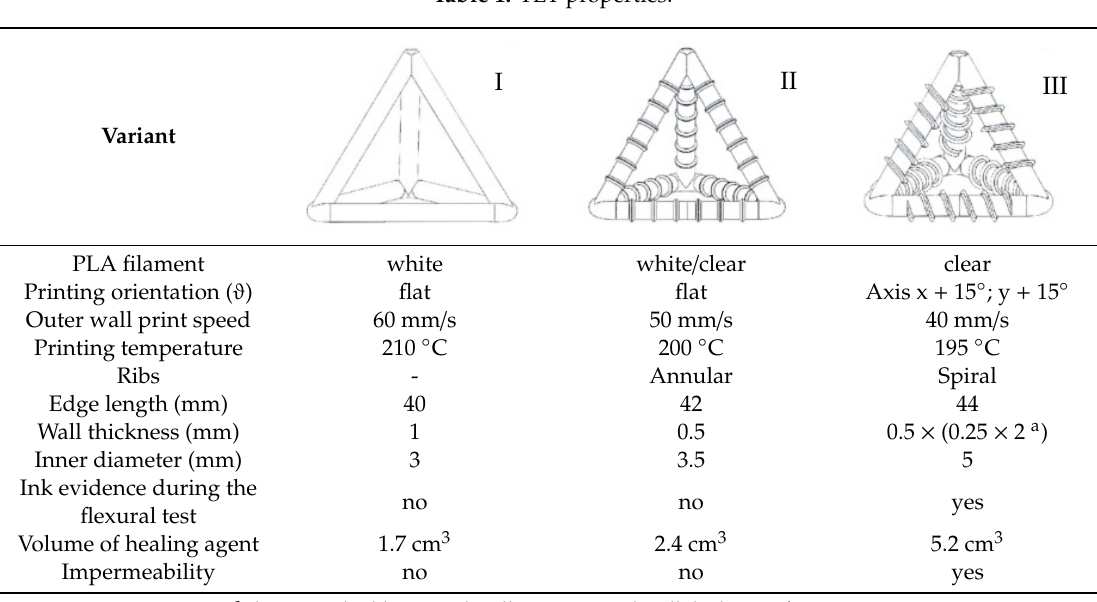
Table 1. TET properties.